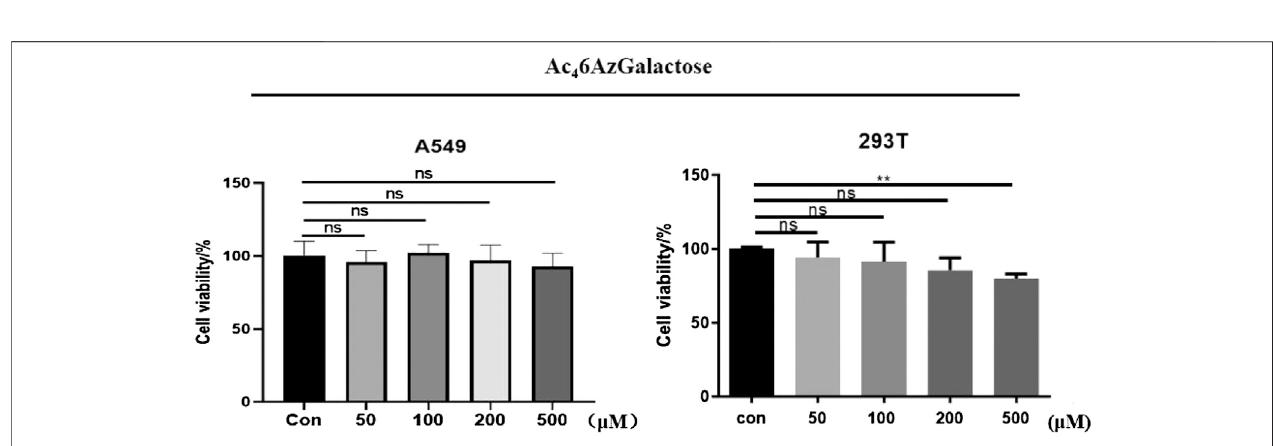
FIGURE2| ViabilityofA549and293TcellswasmeasuredaftertreatmentwithvariousconcentrationsofAc